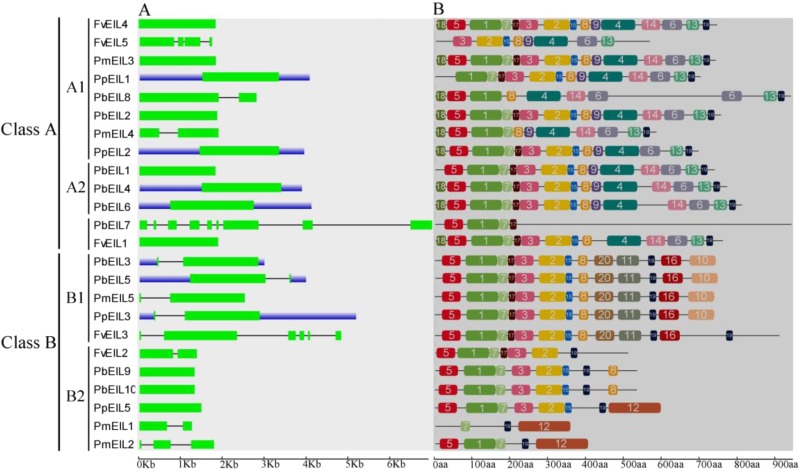
Gene structure (A) and conserved motif compositions (B) of EIN3/EIL genes in Rosaceae species.Untranslated regions (UTRs), introns and exons are represented by blue boxes, thin lines and green rectangles, respectively. Note that the gene or protein lengths can be estimated by using the scale at the bottom.